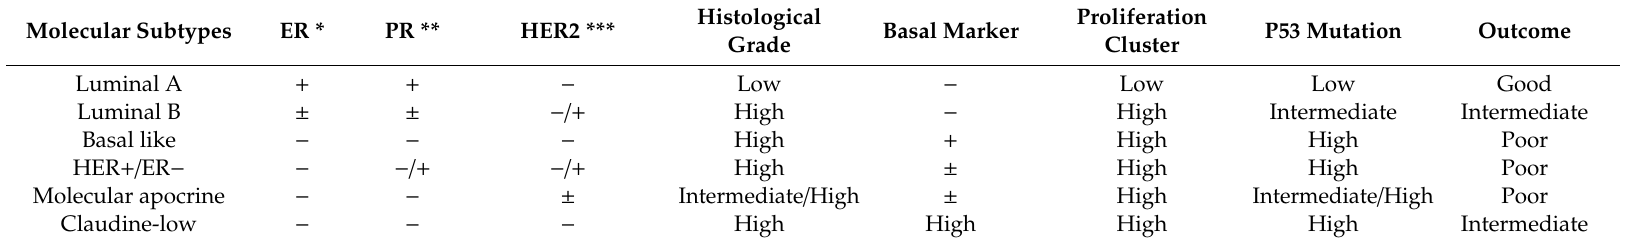
Table 1. Molecular classification of breast cancer (BC) and the respective prognosis